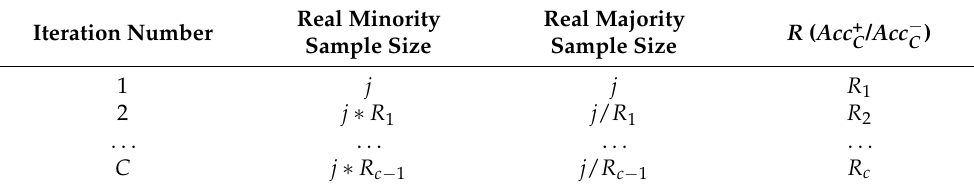
Table 1. The real sample number at each